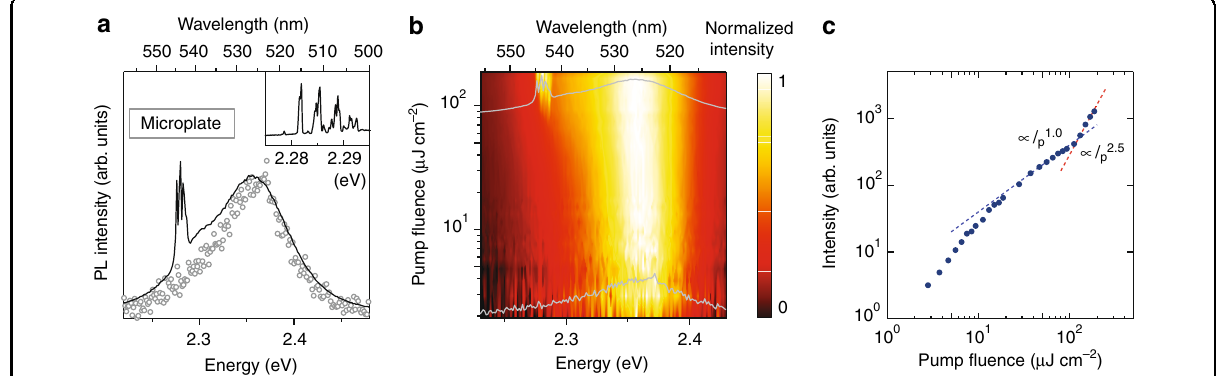
Fig. 3 PL characteristics of CsPbBr 3 bare microplate. a Normalized PL spectra under I p of ~3.8 μ J cm − 2 (open circle) and ~190 μ J cm − 2 (solid line). The data are obtained by integrating the emission within azimuth of <~20°. Inset shows a high-resolution PL spectrum obtained at I p of ~212 μ J cm − 2 . b 2D pseudo-color plot of normalized PL spectra as a function of pump fl uence. As a help to reader, PL spectra obtained under I p of 3.8 μ J cm − 2 and 190 μ J cm − 2 are also shown (gray curves). c Fluence-dependent emission intensity for one of the lasing modes (~2.276 eV). Blue and red dashed lines exhibit linear and super-linear functions representing below- and above-threshold responses,